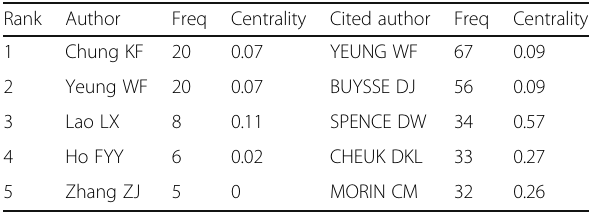
Table 4 Top 5 author and cited author related toacupuncture for insomnia